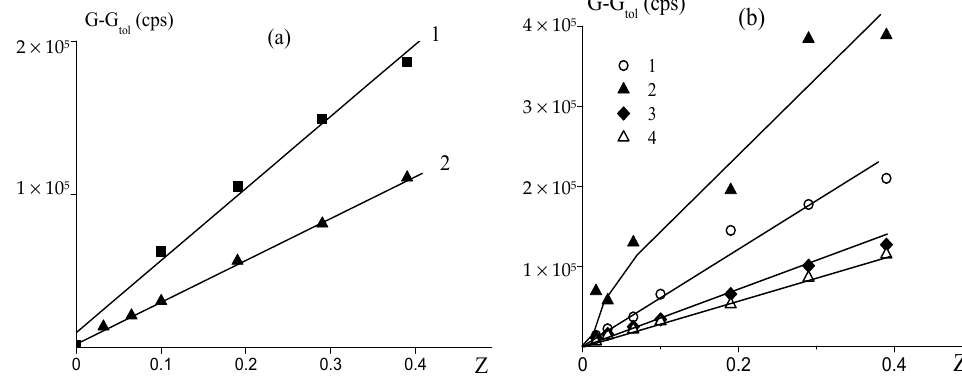
Figure 1. The scattering intensity as a function of the composition Z of the mixtures of non-functionalized PMMA and (1) CdSe non-spherical QDs or (2) CdSe/ZnS QDs ( a ); (1) monochelic M1 —CdSe QDs, (2) telechelic T2 —CdSe QDs, (3) telechelic T1 —CdSe/ZnS QDs, (4) telechelic T2 —CdSe/ZnS QDs ( b ). Here and below, toluene was used as a solvent, C PMMA = 5 mg/mL, T = 25 ◦